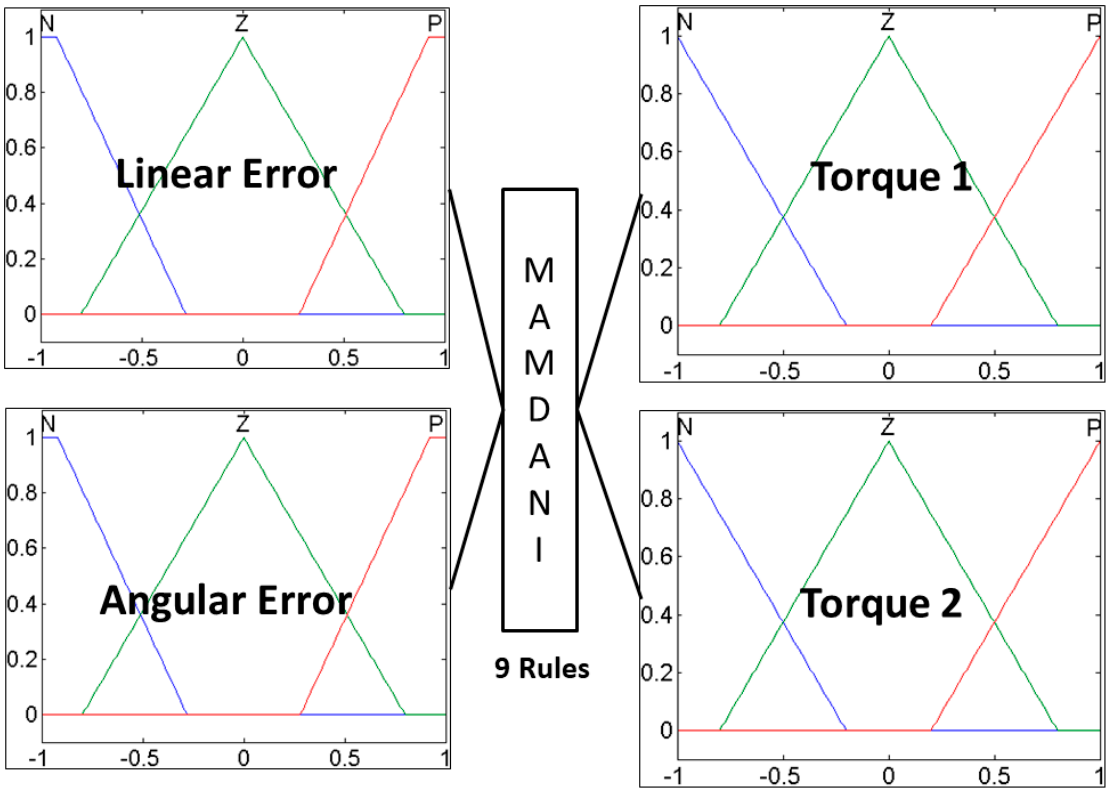
Figure 9. Fuzzy system for control.